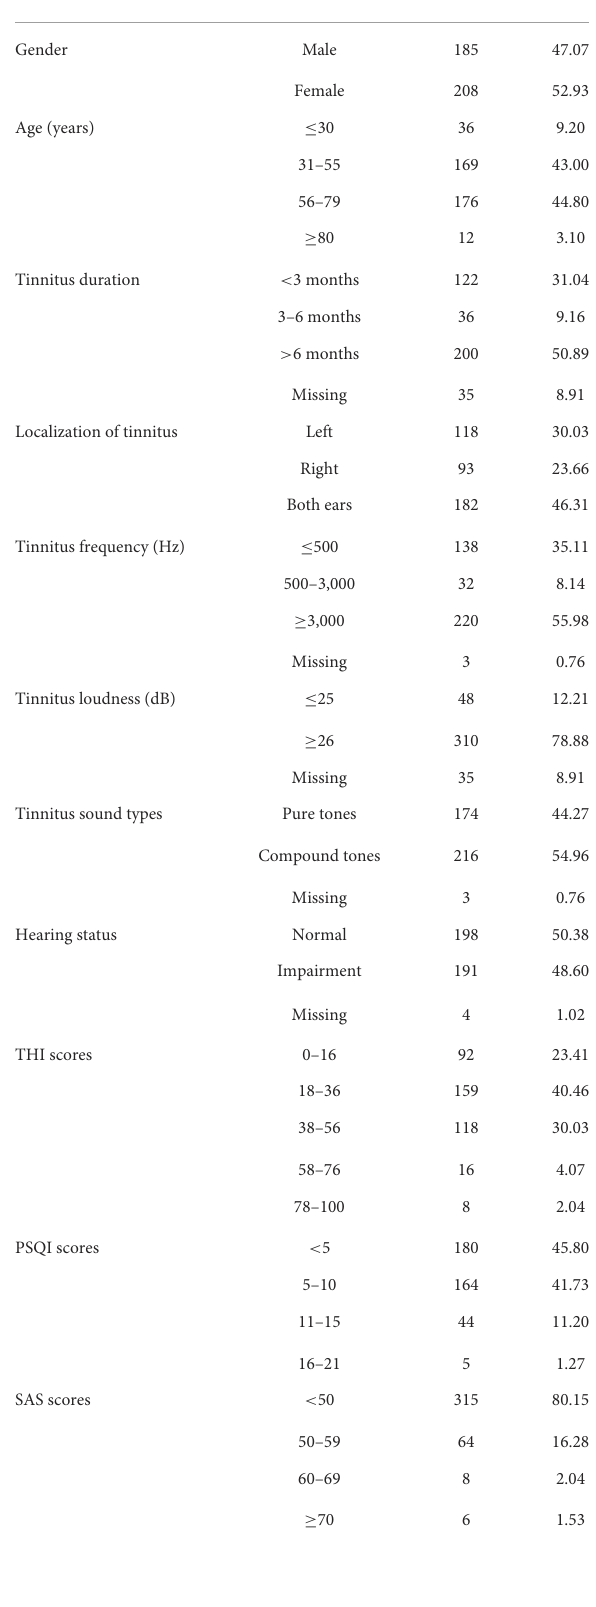
TABLE 1 Clinical characteristics of patients with tinnitus ( n =